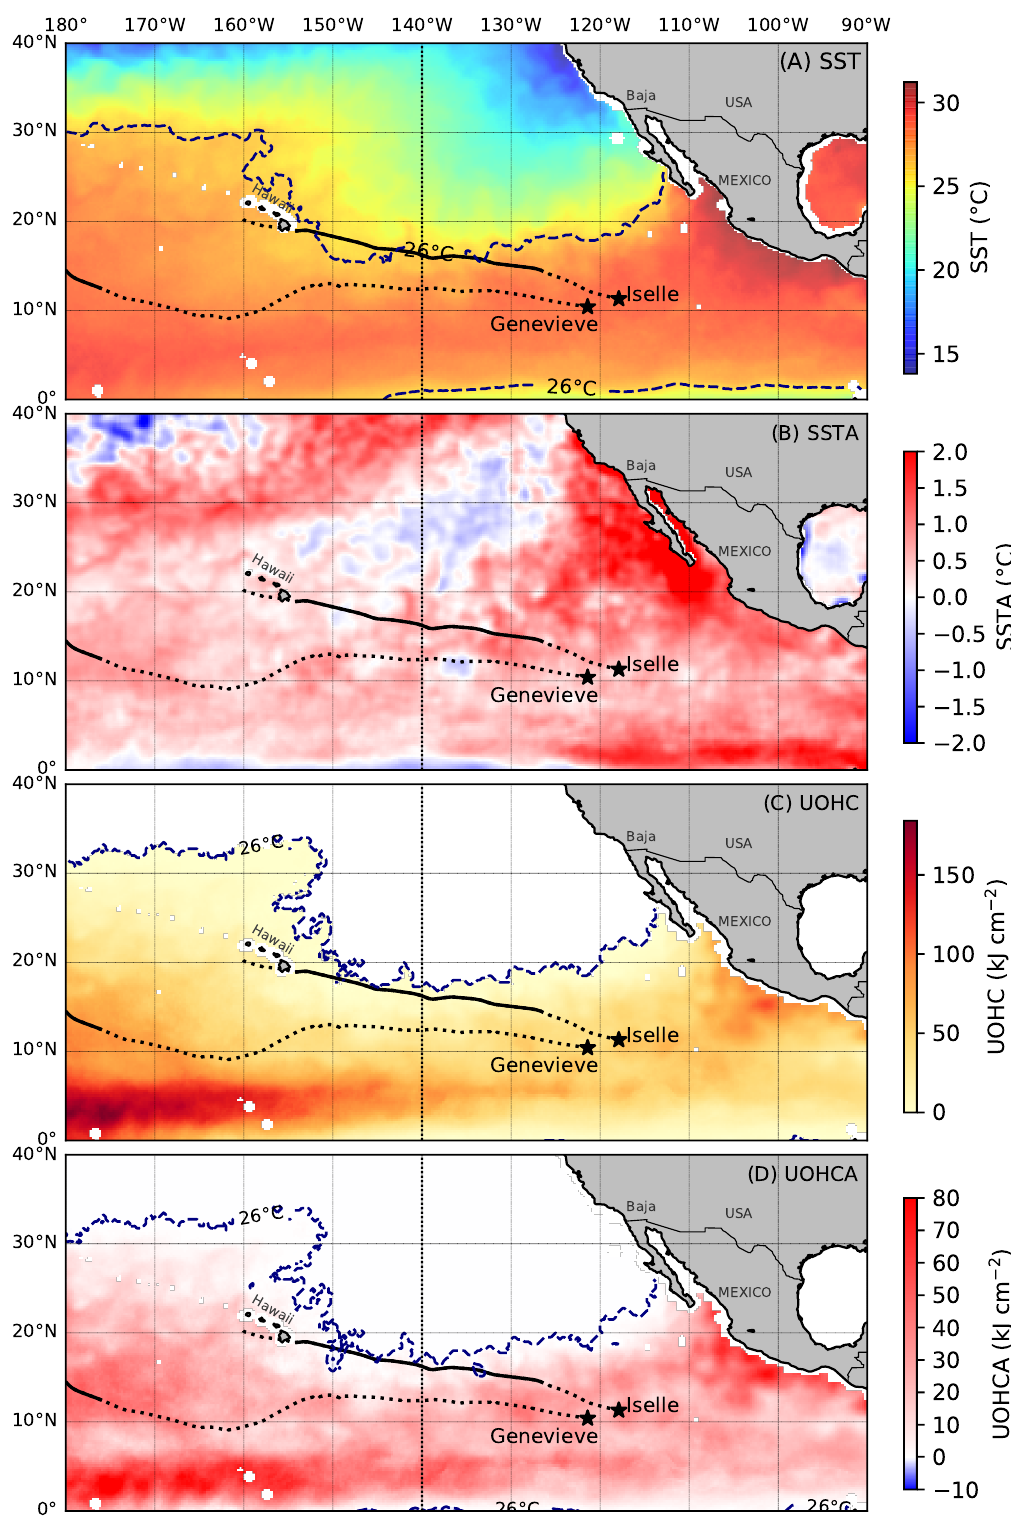
Figure 2. Oceanic conditions and anomalies during July 2014 in the Northeast Pacific Ocean (NPO) as seen in ( A ) sea surface temperature, ( B ) sea surface temperature anomaly, ( C ) upper ocean heat content, and ( D ) upper ocean heat content anomaly. The surface location of the 26 ◦ C isotherm is contoured in blue for reference. The trajectories of Hurricanes Genevieve (25 July–7 August) and Iselle (31 July–9 August) are provided, with a star representing the genesis location. TC trajectory denoted by: black dashed line for tropical storm status (below 33 ms − 1 ) and thick black line for hurricane status (above 33 ms − 1